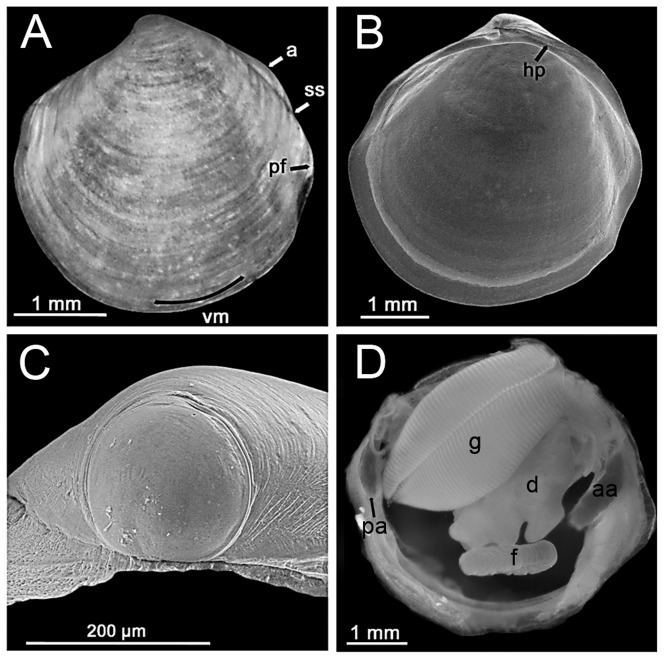
Morphology of Thyasira cf. gouldi from Bonne Bay, Newfoundland.
A. Outer view of the left shell valve, with a weakly projecting auricle (a), a well-defined submarginal sulcus (ss) forming a marginal sinus, a distinct, yet rounded, posterior fold (pf), and a rounded ventral margin (vm). B. Inner view of the right valve, revealing the absence of dentition along the hinge plate (hp). C. Scanning electron micrograph of the larval shell (∼ 181 μm diameter). D. Internal anatomy, showing a gill (g) with two demibranchs, the digestive diverticula (d), foot (f), anterior adductor (aa), posterior adductor (pa) and mantle margin, thickened at the anterior end.